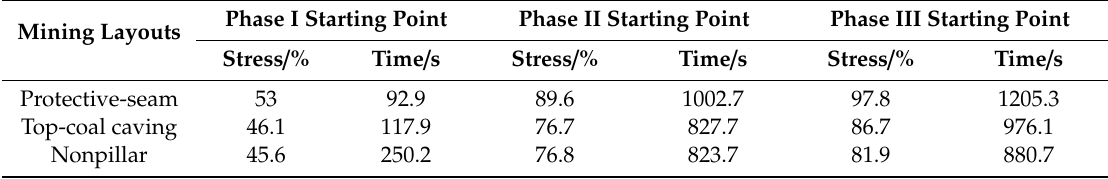
Table 1. Statistics of stress and time for typical stages of AE activity under di ff erent mining